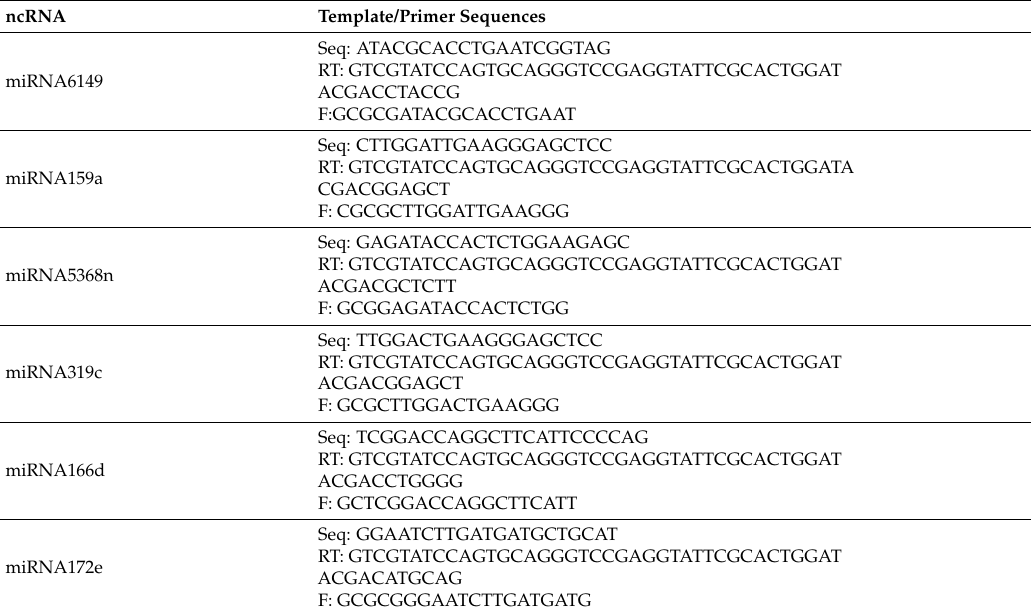
Table 1. Templates and primers for